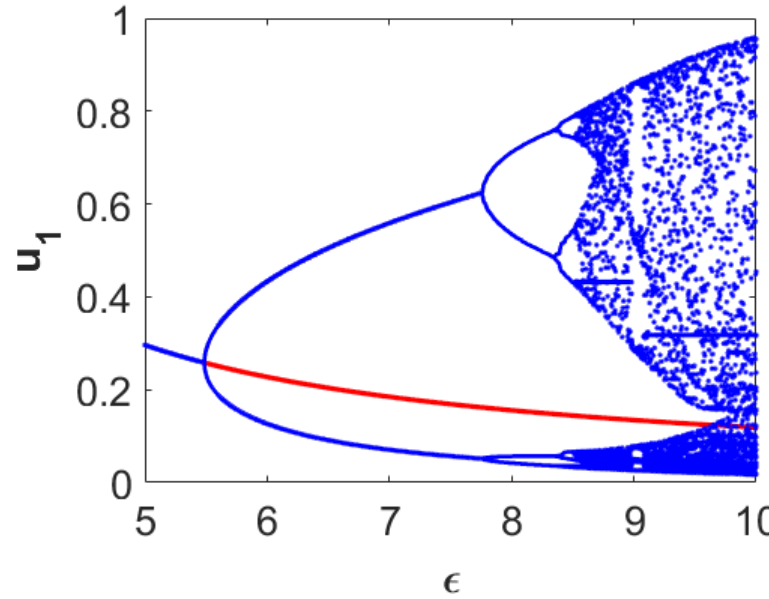
Figure 1. Single parameter bifurcation diagram for the density of first prey population ( u 1 ) with respect to the parameter (cid:101) for the temporal model (1)–(3). Other parameter values are mentioned in